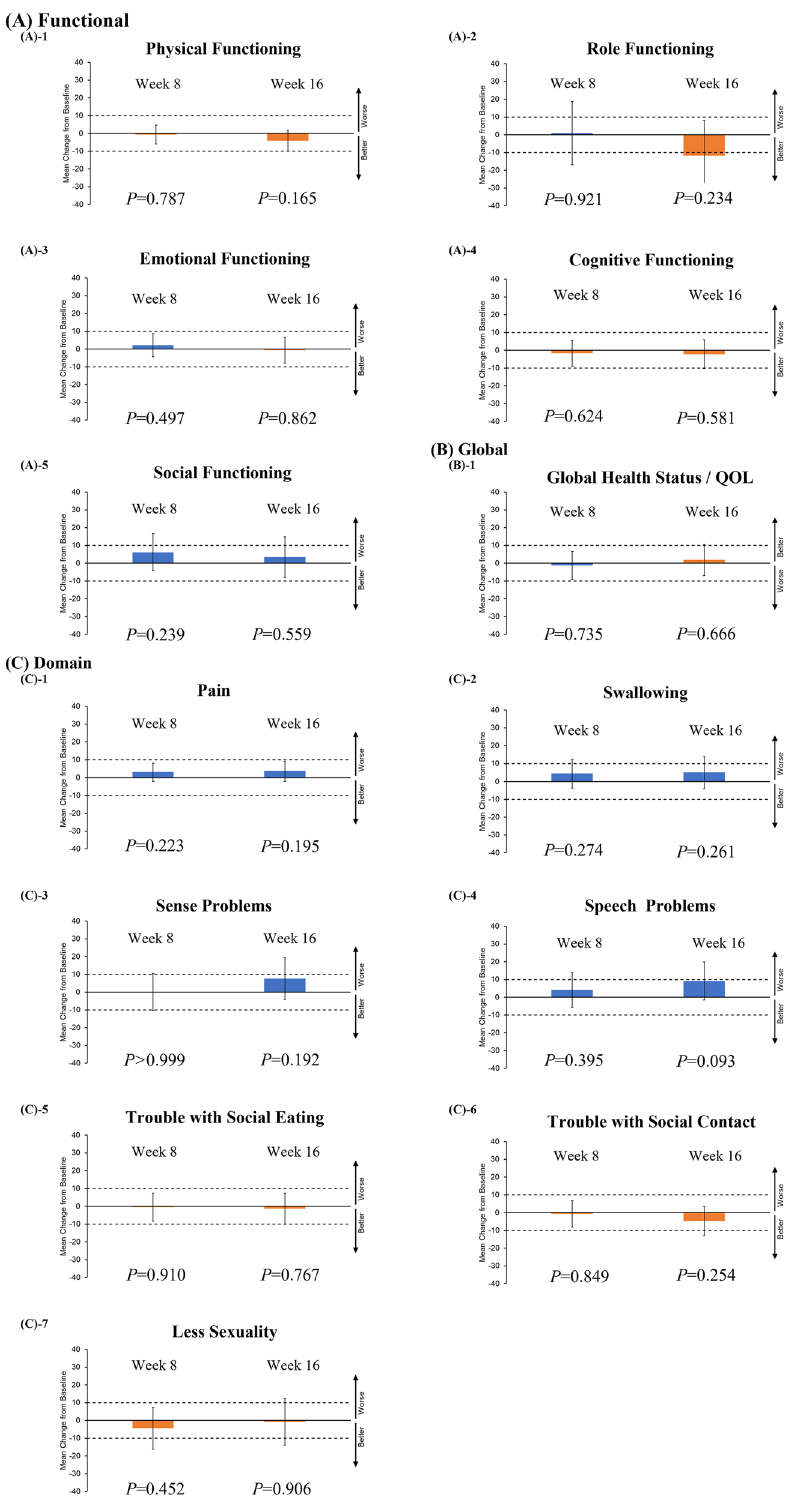
Figure 3. Quality of life assessments. ( A ) Functional scales (physical, role, emotional, cognitive, and social activities) and ( B ) global health status were assessed using the EORTC QLQ-C30. ( C ) Domain scales (pain, swallowing, sense problems, speech problems, trouble with social eating, trouble with social contact, and reduced sexuality) were assessed using the QLQ-H&N35. All scales ranged from 0 to 100, and score changes of at least 10 points (dashed line) were considered clinically significant. Higher values for functional and domain scales indicate poor functioning, whereas higher values for global health status indicate better functioning. The I bar indicates a 95% confidence